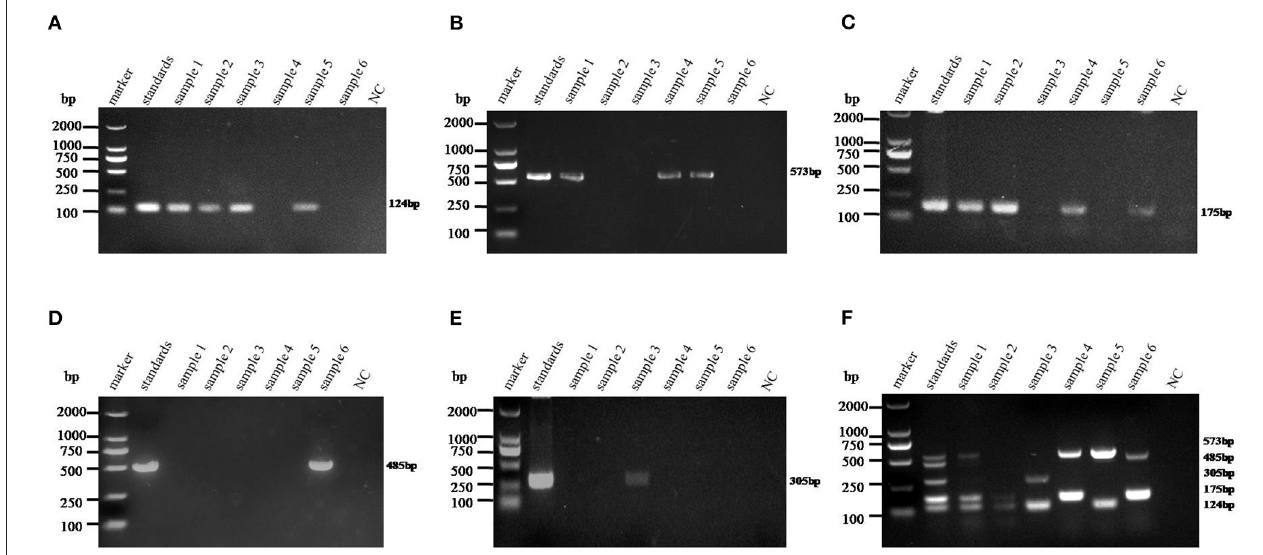
FIGURE 6 | Detection consistency analysis of multiplex and monoplex PCR used in this study. The standards of each genotype were mixed as a template pool and used as a positive control. The cDNAs of selected samples were used as templates for monoplex and multiplex PCR in the optimized PCR system. (A–E) Porcine astrovirus (PAstV) one to five genotype monoplex PCR results of the selected positive samples. (F) Multiplex PCR result of the selected positive samples. The indicated sizes of each genotype are shown in the right panel.